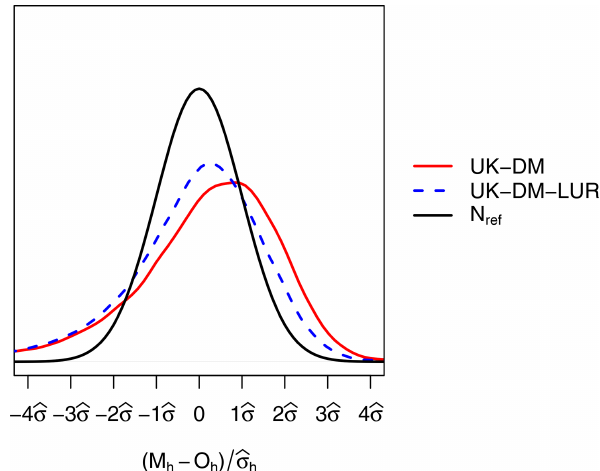
Figure 8. PDF of the hourly bias, normalized by the universal krig- ing standard deviation, for all monitoring stations in LOOCV dur- ing 2019. The PDFs correspond to the reference normal distribution ( N ref ), UK-DM, and UK-DM-LUR hourly results.